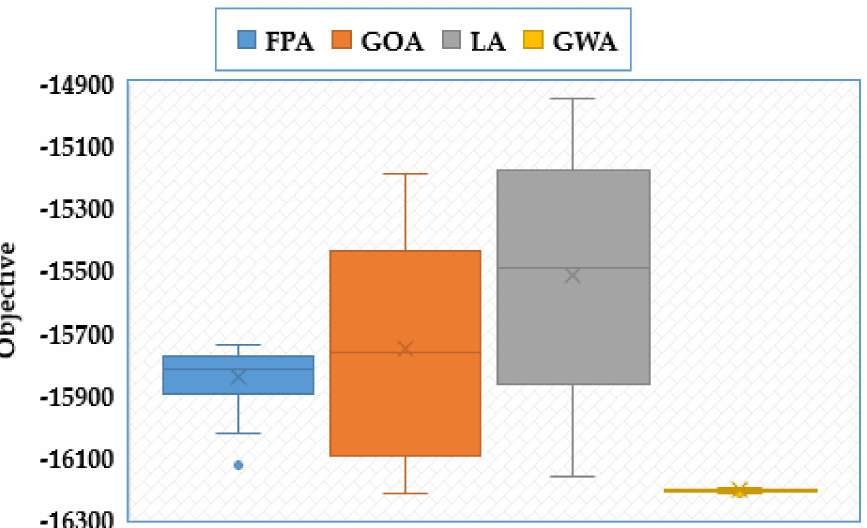
Figure 9. Box and Whiskers plot of GWA, FPA, LA, and GOA for TLSM design under second case. Table 5. Robustness indices of GWA, FPA, LA, and GOA for TLSM design under second case. Robustness Indices